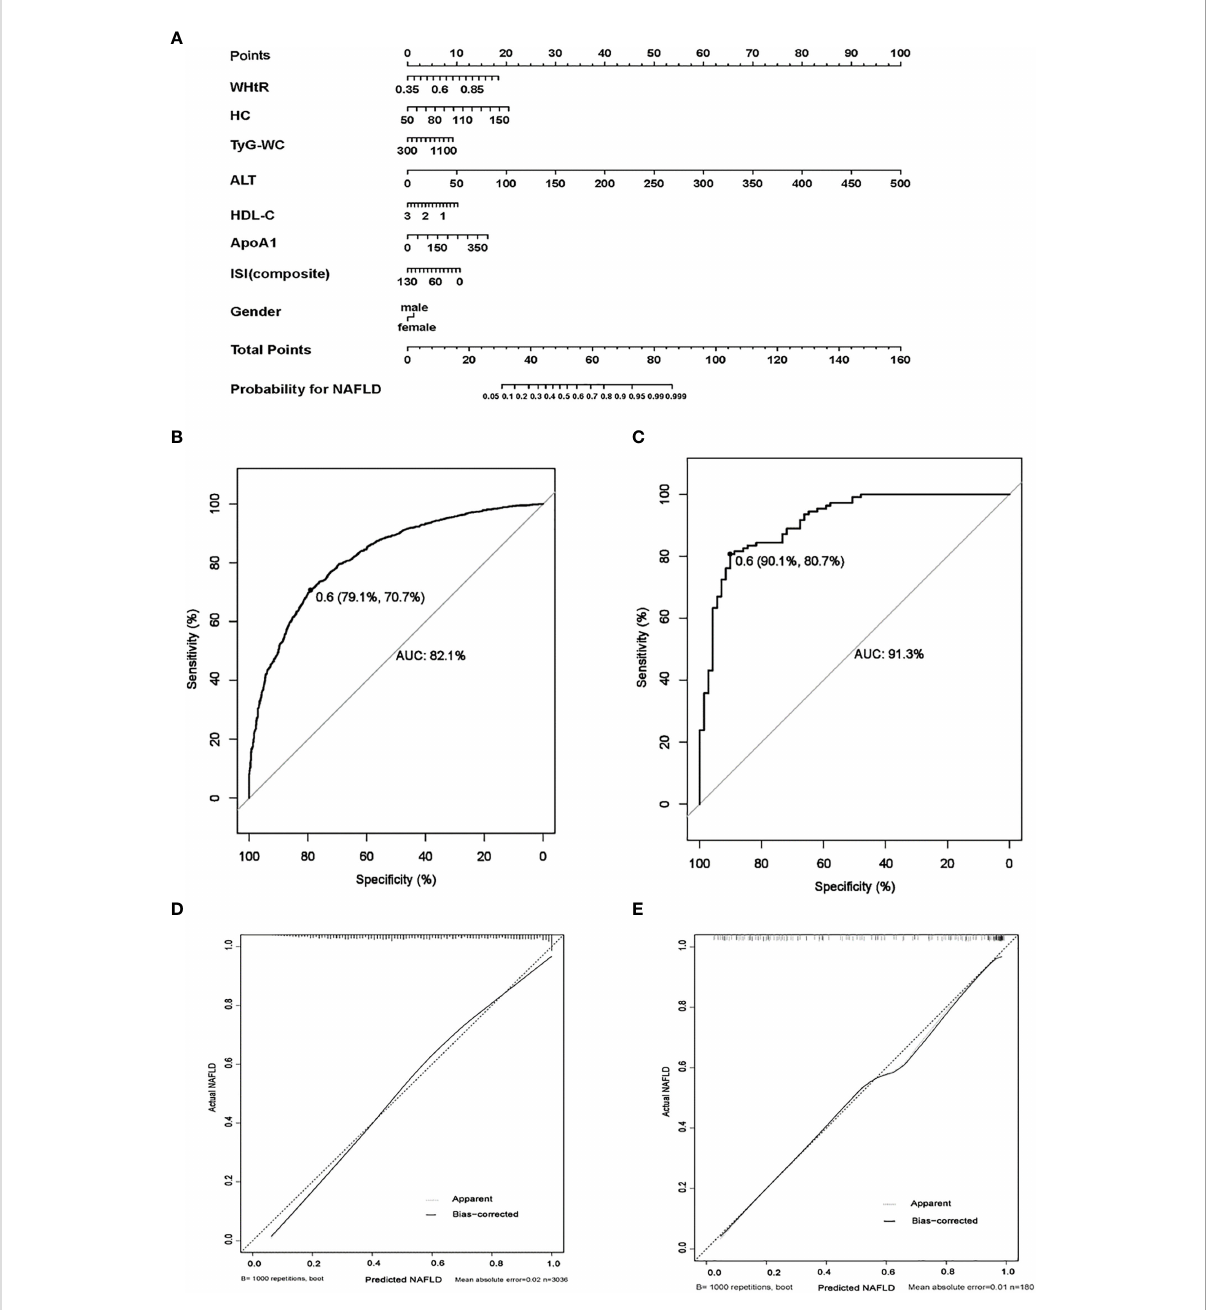
FIGURE 3 The establishment and validation of a clinical predicting model for childhood NAFLD. (A) Nomogram model for predicting childhood NAFLD. (B) Receiver operating characteristics (ROC) curves for predicting NAFLD in the training set, the AUROC of the model is 0.821 (95% CI 0.806 – 0.835, p < 0.001) with the sensitivity and speci fi city of 70.70% and 79.10%, respectively. (C) ROC curves for predicting NAFLD in the validation set, the AUROC of the model is 0.913 (95% CI 0.879 – 0.960, p < 0.001) with the sensitivity and speci fi city of 80.70% and 90.10%, respectively. (D, E) : calibration curves for assessment of the performance of the nomogram in the training set (D) and the validation set (E) . (1000 bootstrap resamples). Nomogram predicted probability of NAFLD is plotted on the x-axis; actual probability is plotted on the